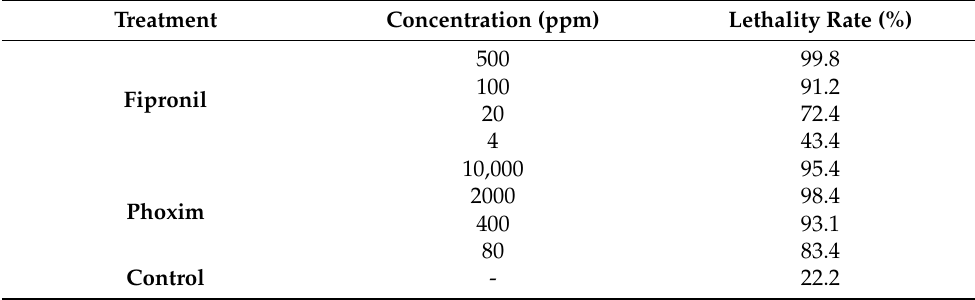
Table 2. Lethality rates for each concentration and molecule.